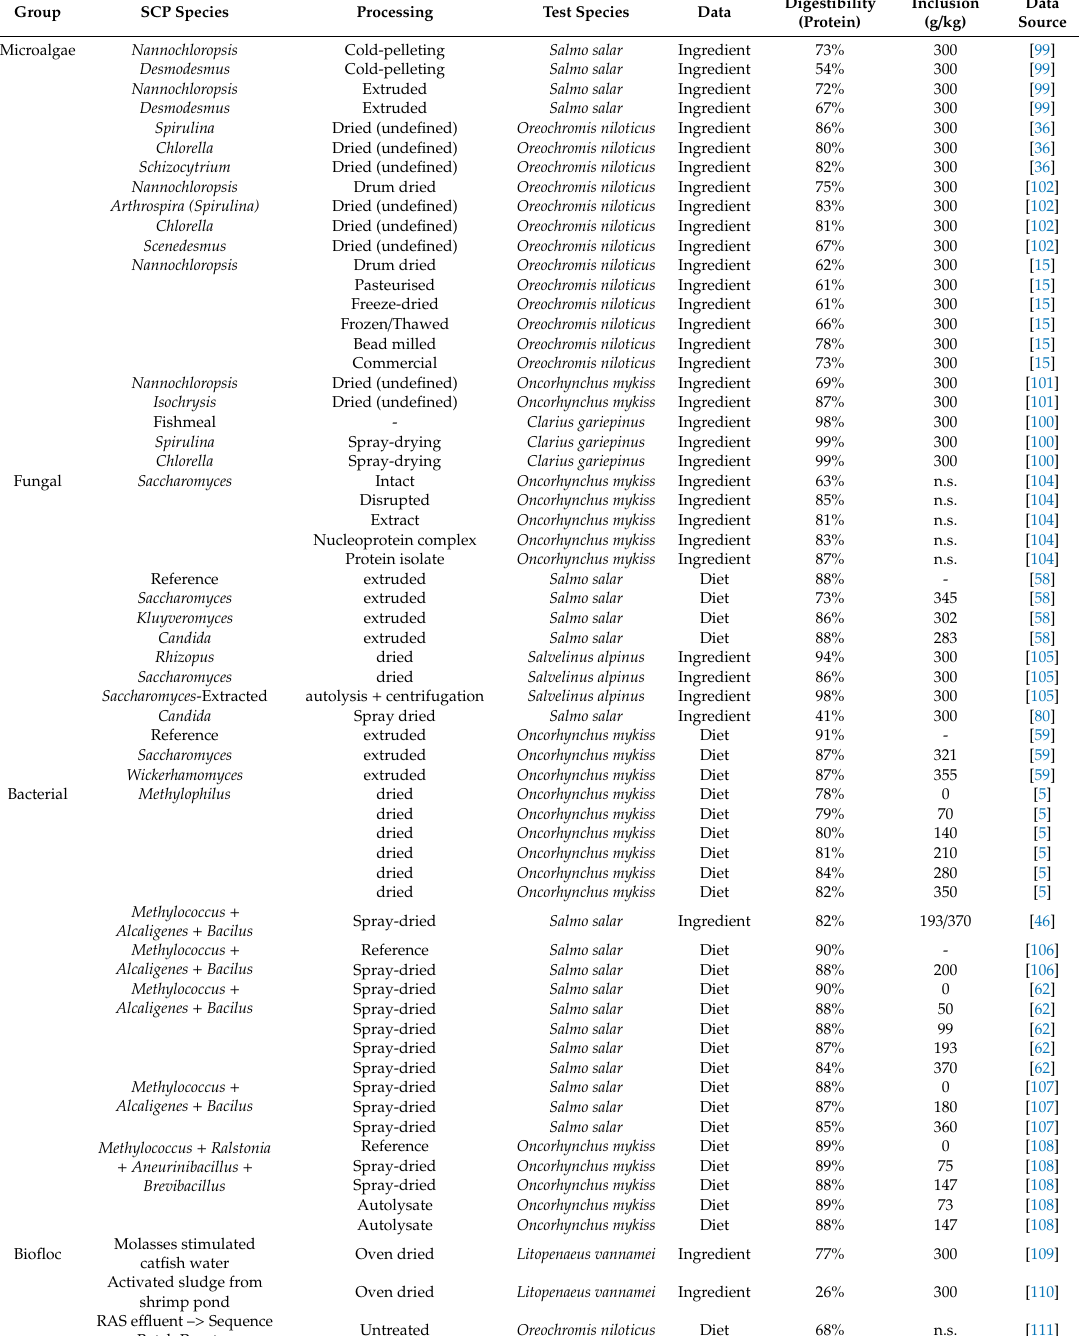
Table 4. Influence of material and processing on protein digestibility of various SCP products.